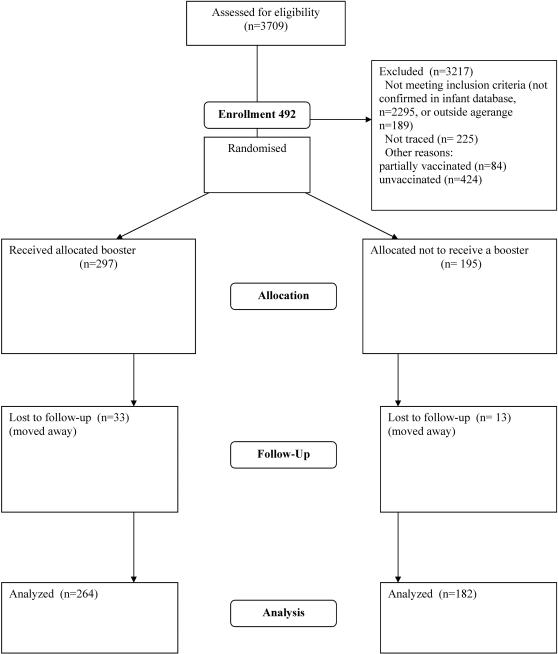
Flowchart HBV booster allocation.